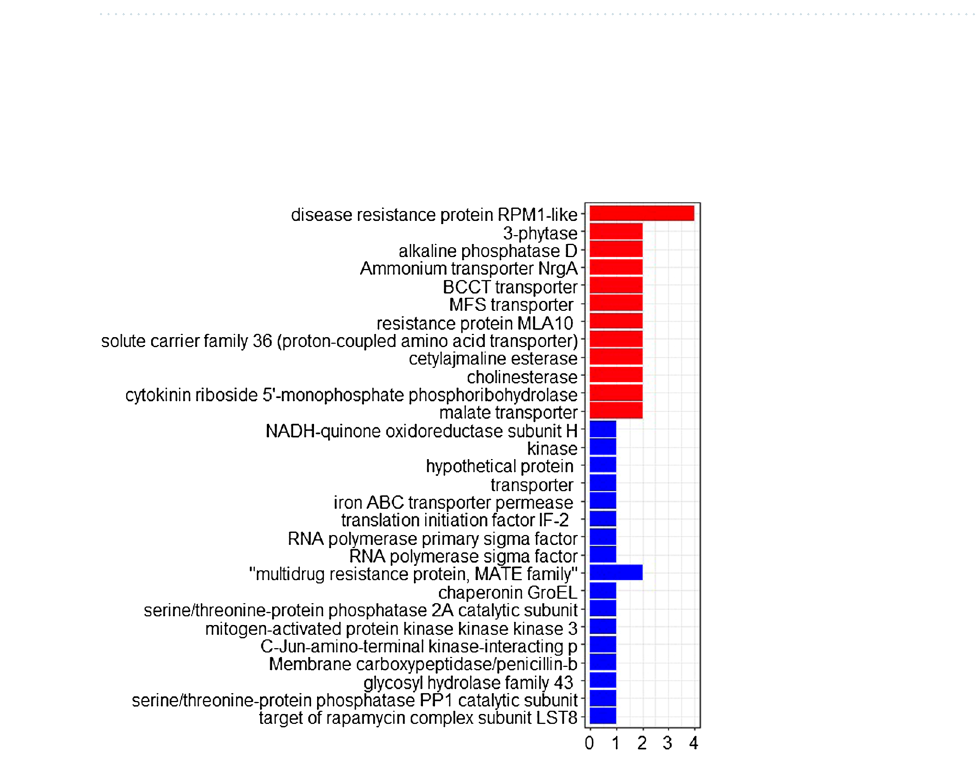
Figure 5. GO annotation clustering map of the candidate genes.